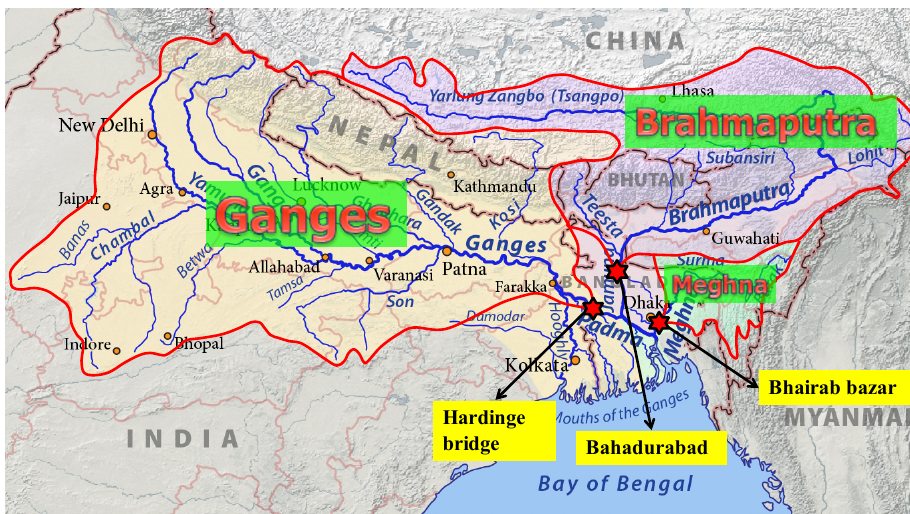
Figure 1. The Ganges–Brahmaputra–Meghna (GBM) basin (modified from Pfly, 2011).